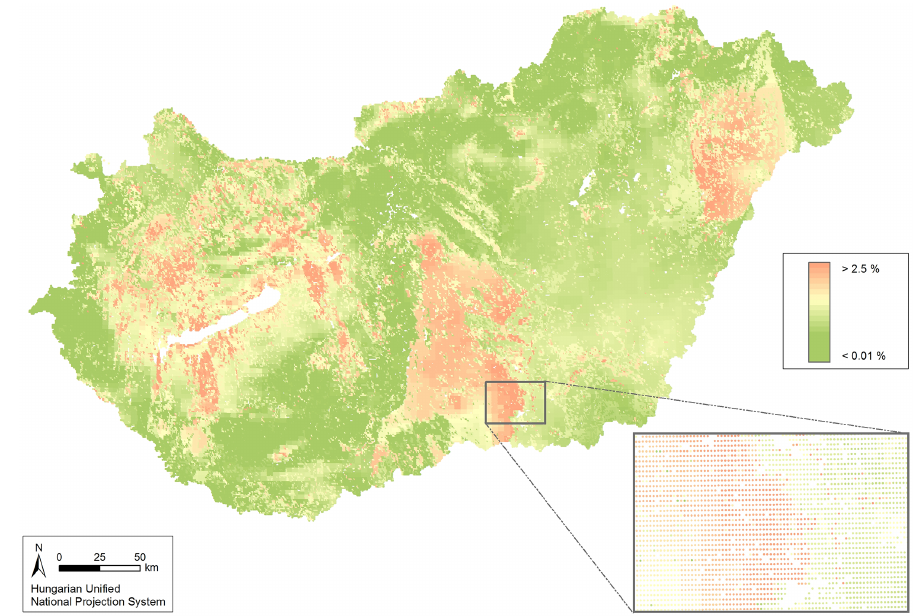
Figure 7. Probability values of hourly wind speed exceeding critical values (2000–2013) calculated for the 0.5 (cid:48) resolution grid points. Table 3. The extent of wind-susceptible areas in Hungary. Spatial distribution based on Spatial distribution based our combined